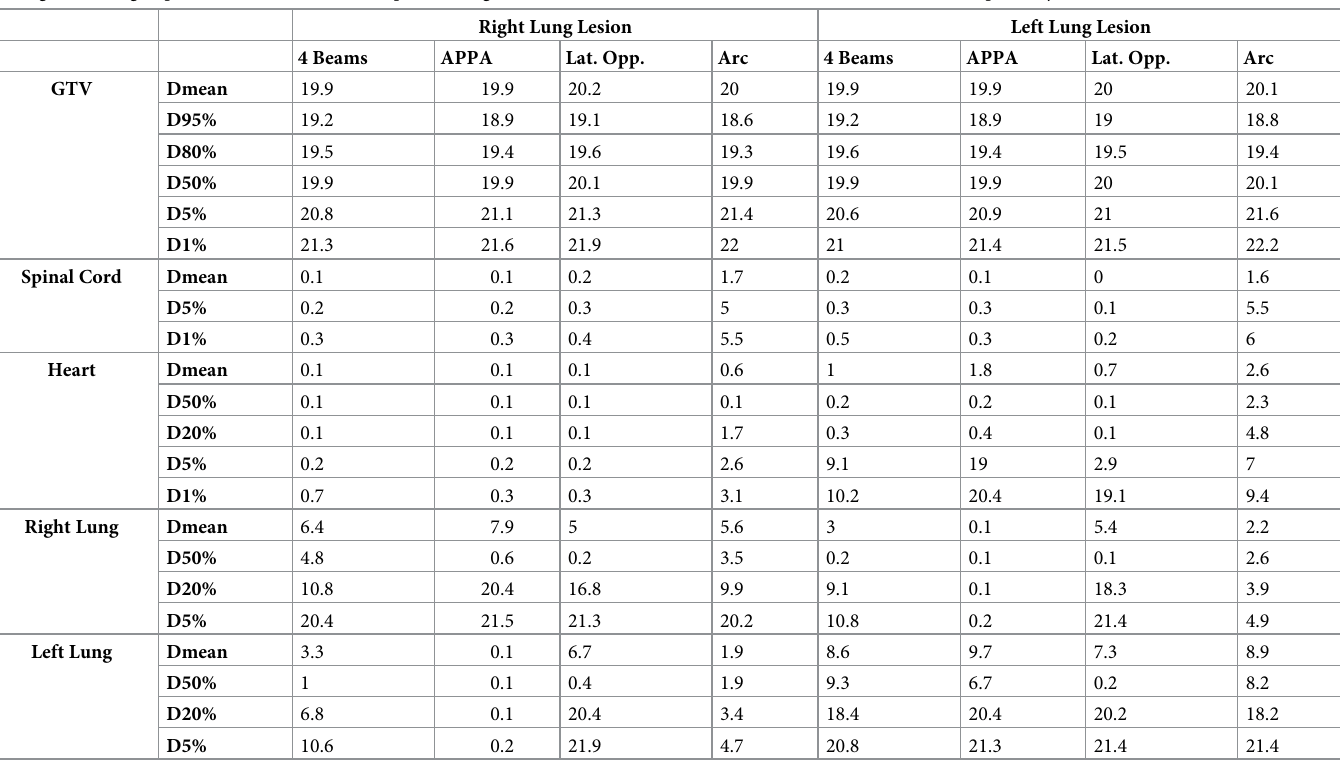
Table 1. Dose values, in Gy, for all four treatment plans including: 1) two sets of perpendicular staggered parallel opposed fields with avoidance of both spinal cord and heart (denoted 4 Field), 2) two fields positioned in the AP-PA configuration (denoted AP-PA), 3) two parallel opposed fields which crosses through the contra- lateral lung as well as the target with avoidance of both heart and spinal cord (denoted Lat. Opp.), and 3) an 180˚ arc field from 0˚ to 180˚ (denoted Arc). The mean dose (Dmean), dose to 95%, 80%, 50%, 20%, 5% and 1% of the structure volume are listed (rows) for each of the five contoured structures. Volumes for both the representa- tive right and lung implanted lesion, for which the plans were generated, and values were calculated for, were 8 and 7 mm 3 respectively. Right Lung Lesion Left Lung Lesion 4 Beams APPA Lat. Opp. Arc